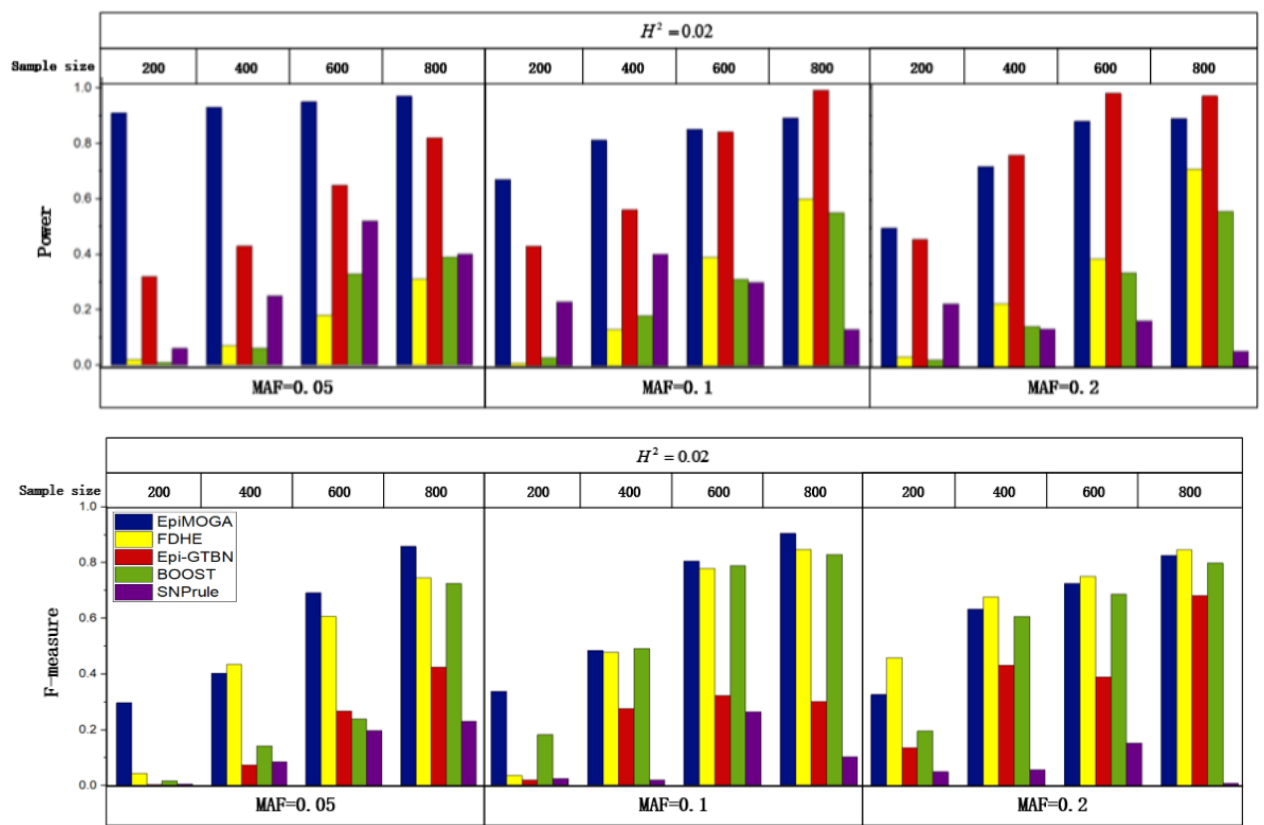
Figure 3. Detection efficiency and accuracy comparisons between EpiMOGA and other methods on the DME2 model with different MAF and sample sizes.